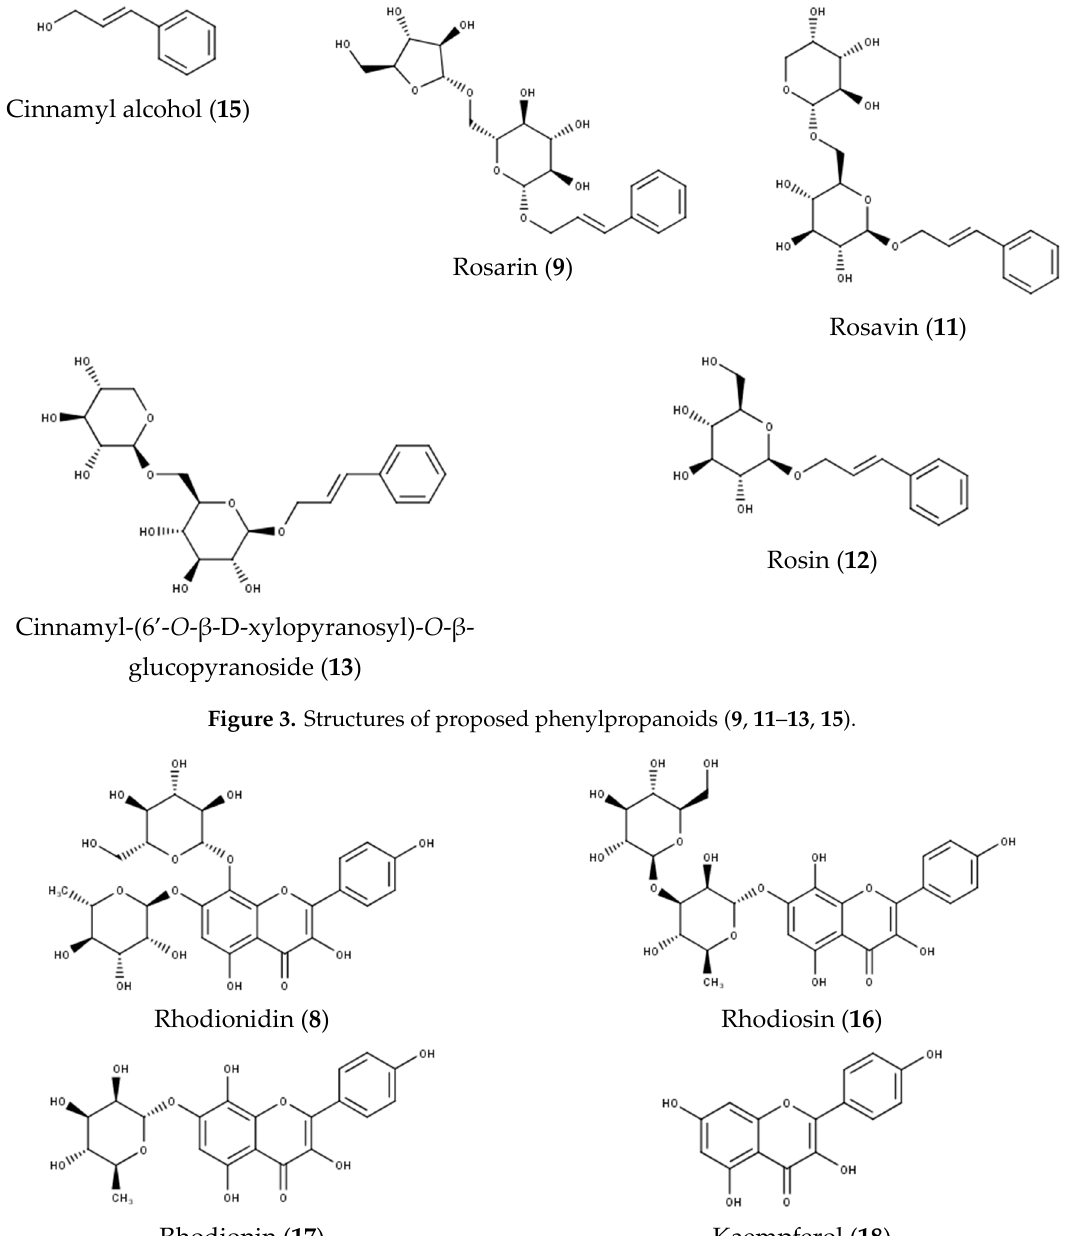
Figure 2. Structure of proposed compound epigallocatechin-3- O -gallate ( 6 ).